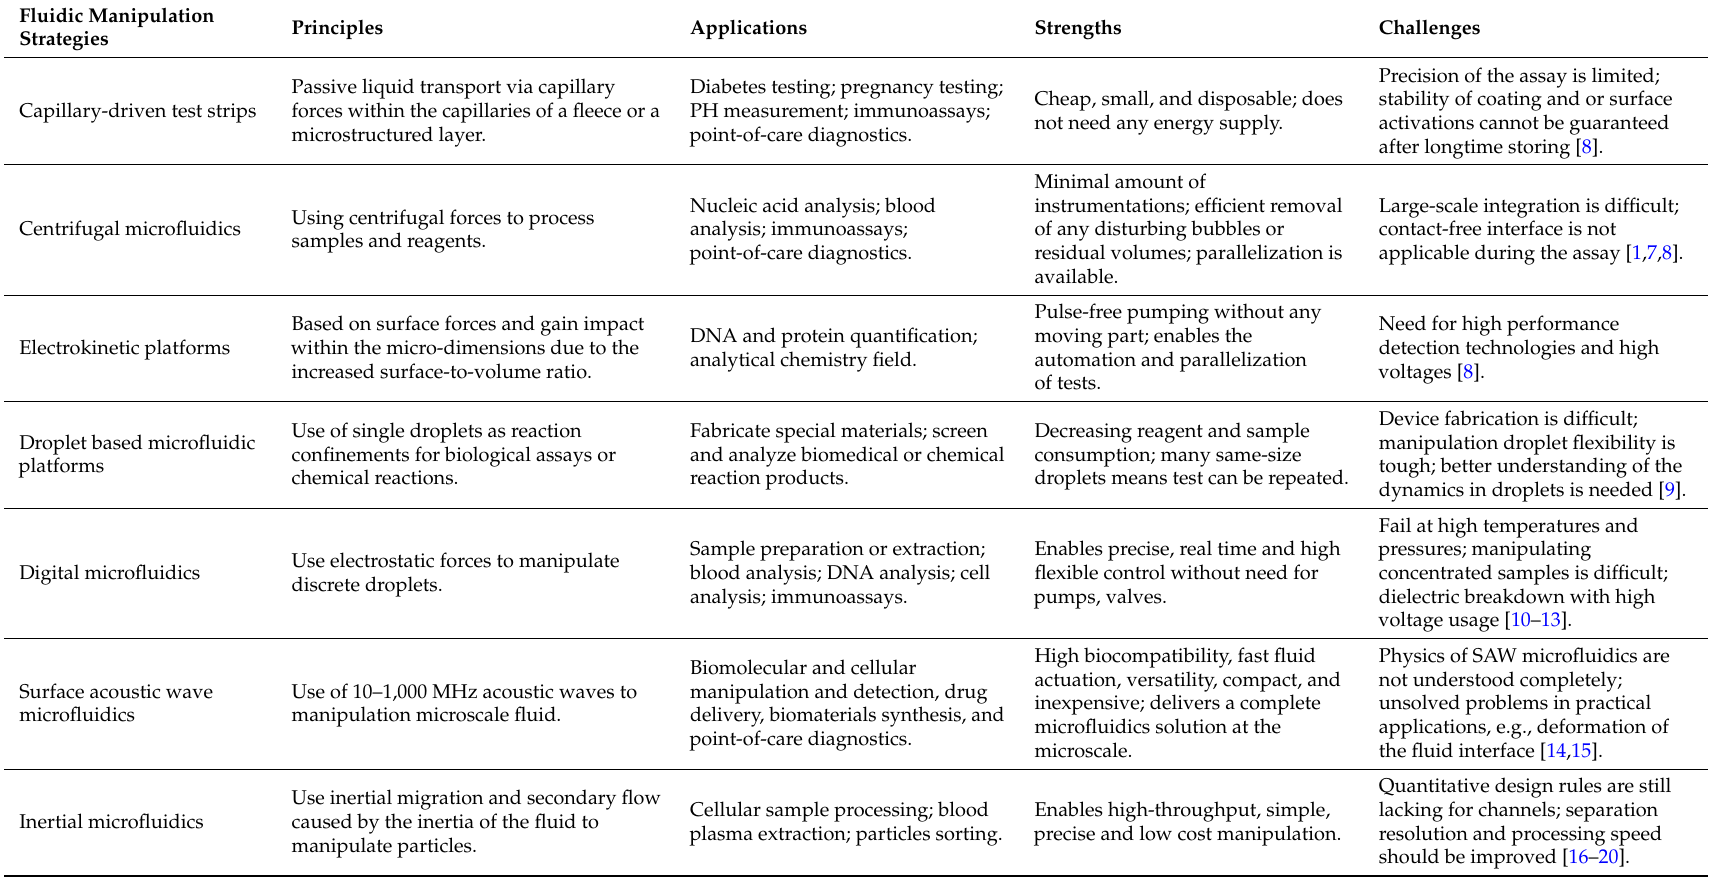
Table 1. Comparison of different fluidic manipulation strategies in microfluidics in recent